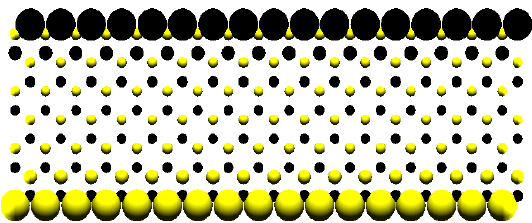
Figure 2. (Color on-line). Pictorial representation of the local spin-polarization for an ideal ZGNR device (unstrained). Yellow (black) corresponds to a net spin-up (down). The magnitude of the spin-polarization (Equation 3) is indicated by the circle